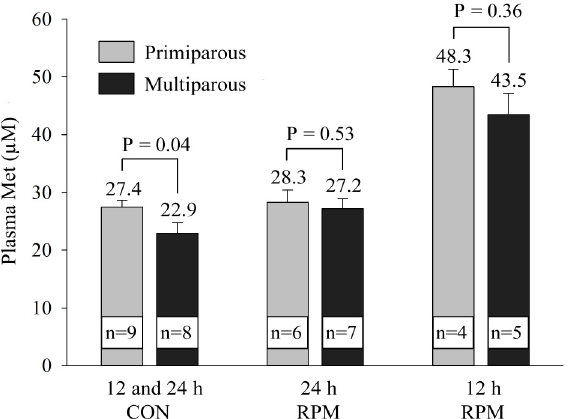
Fig 3. Concentrations of plasma Met analyzed by parity for CON cows at 12 and 24 hours (averageof all values), RPM at 12 hour, and RPM at 24 hour after feeding and RPM feeding. CON at 12 and 24 hours (primiparous = 9 composites; multiparous = 8 composites); RPM at 24 hour (primiparous = 6 composites; multiparous = 7 composites); RPM at 12 hour (primiparous = 4 composites; multiparous = 5 composites). Each composite contains4 to 5 cows.